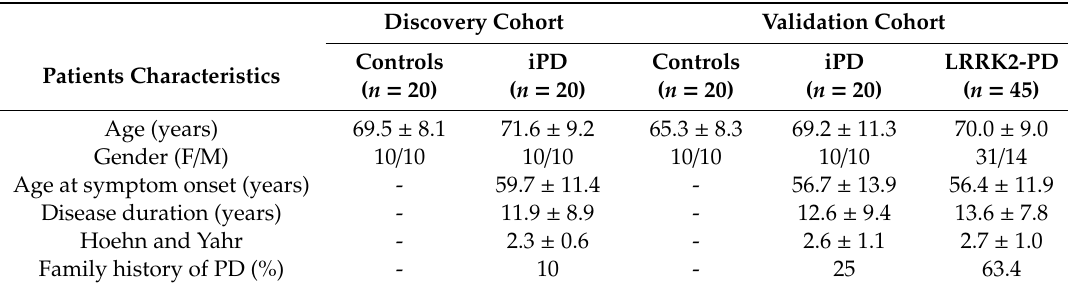
Table 1. Clinical characteristics of patients and controls in each cohort. Data are presented as mean ± standard deviation. iPD, idiopathic Parkinson’s disease; LRRK2-PD, LRRK2 mutation Parkinson’s disease. Discovery Cohort Validation Cohort Controls Patients Characteristics ( n =